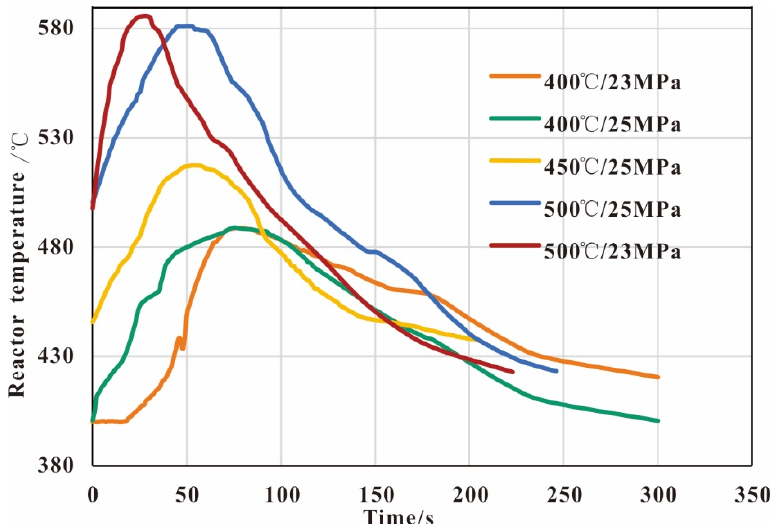
Figure 9. Temperature changes in the reactor during the experiment of supercritical water–diesel reactions under different initial temperature and pressure conditions.